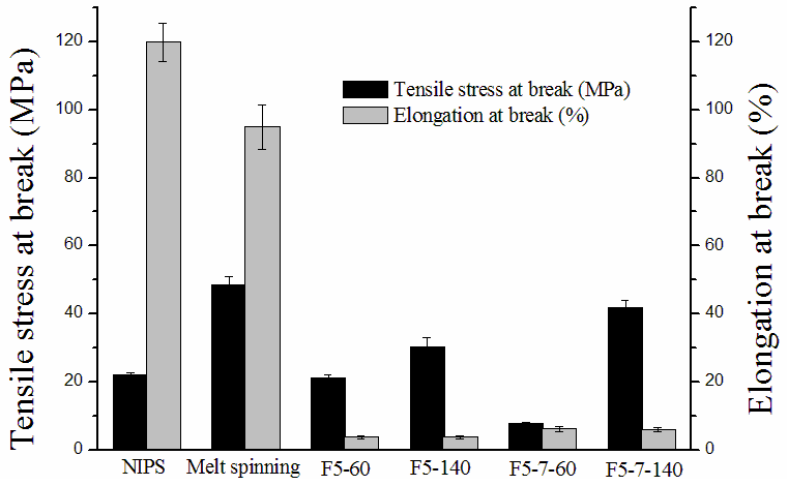
Figure 9. Mechanical properties of PVDF membranes with different preparation